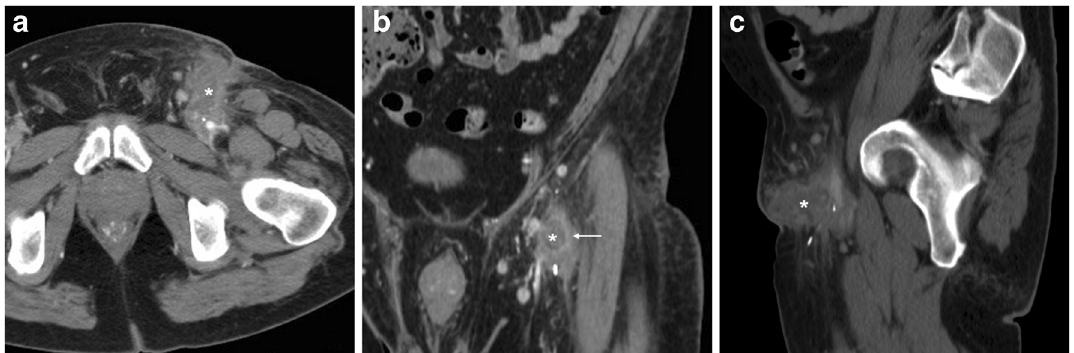
Fig. 10 Groin abscess developing from superinfection of an iatrogenic haematoma in a 56-year-old man with acute coronary syndrome treated with PCI. Axial (A) and coronal (B) contrast-enhanced CT images Fig. 11 Two different cases of septic thrombophlebitis (STP) af- ter intravenous drug injection. A- B) in a 57-year-old HIV- seropositive male patient, contrast-enhanced CT images showed strongly enhancing B tram-track ^ fistula (arrowheads) along the puncture track, and similar mural enhancement of the thrombosed ipsilateral femoral vein (arrows). Pus culture from draining orifice tested positive for Methycillin-sensitive Staphylococcus aureus . C-F) in a 34-year-old man with high fever, right thigh swelling, bloody and purulent drainage at the groin. The non-opacified right common, external iliac and femoral veins (arrows in C, D) showed promi- nent wall enhancement and some endoluminal gas bubbles. A B tram-track ^ fistula connected to the depressed injection site (ar- rowhead in C). Additionally, body CT showed pleural effu- sions, lungbaseconsolidation(+), mediastinal adenopathies and subpleural lesions with central cavitations consistent with septic emboli (thick arrows in E, F). Blood and groin pus cultures re- vealed polymicrobial infection, which required two months of antibiotics and intensive care hospitalisation [Adapted with permission from ref. no. [39]]